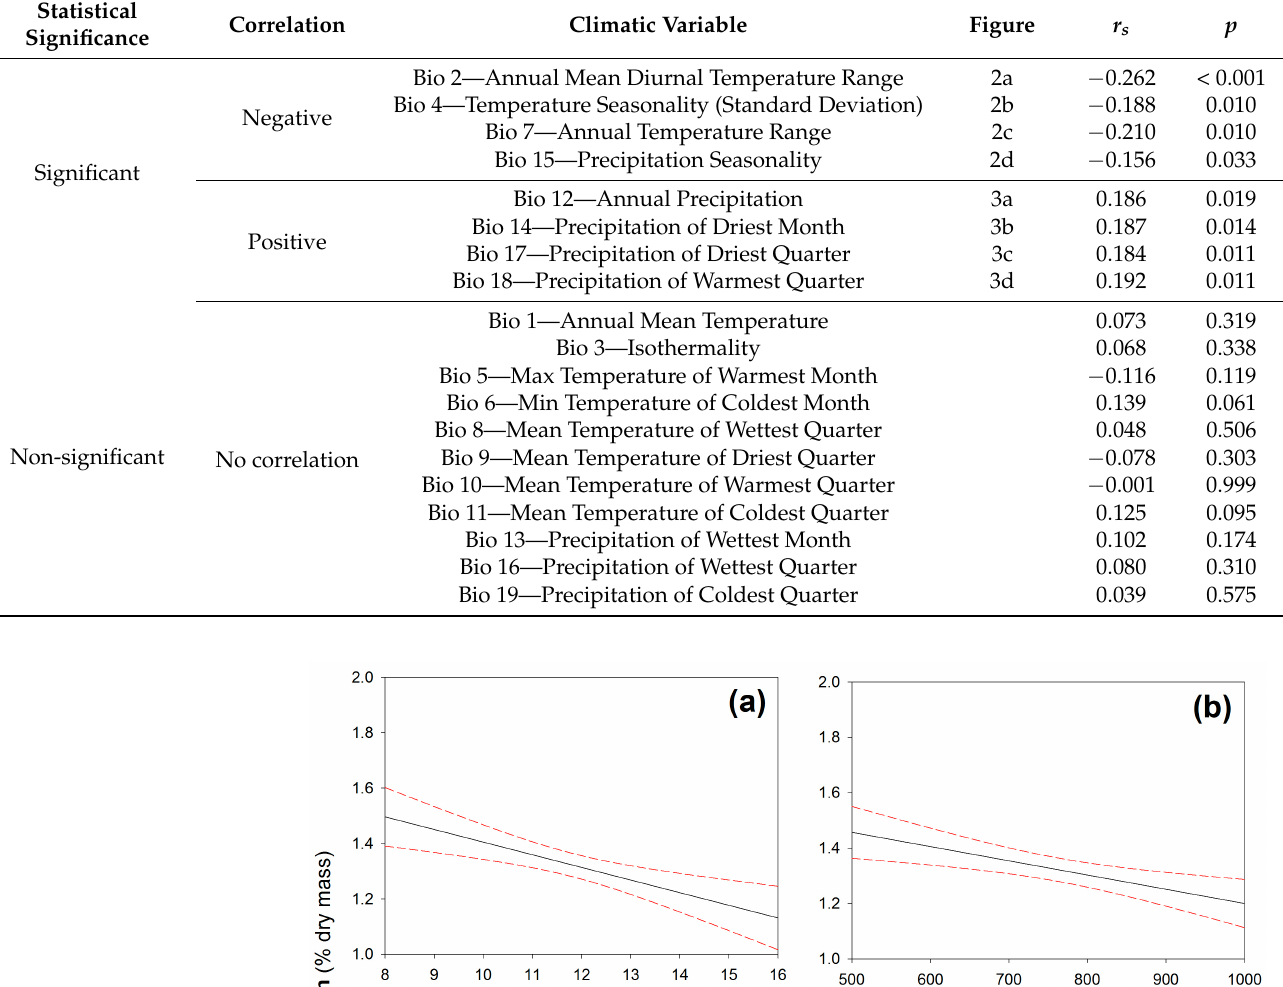
Table 1. Correlation test results for leaf Si concentrations and climatic variables for plants grown under low-Si soil conditions. p values corrected to account for multiple testing using the Benjamini and Hochberg False Discovery method [25].